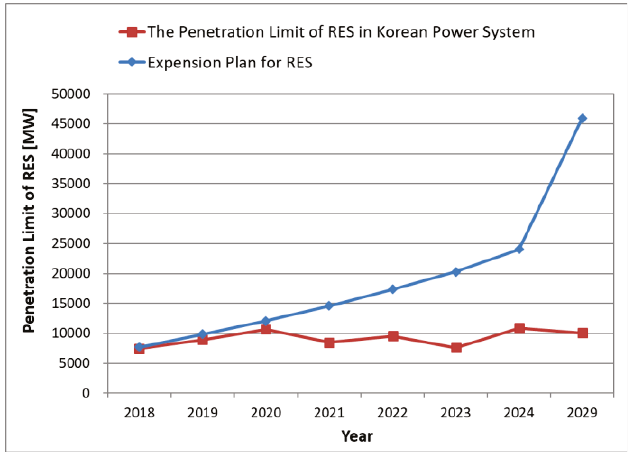
Figure 11. Comparison of the determined penetration limit and planned capacity of RES in Korea.